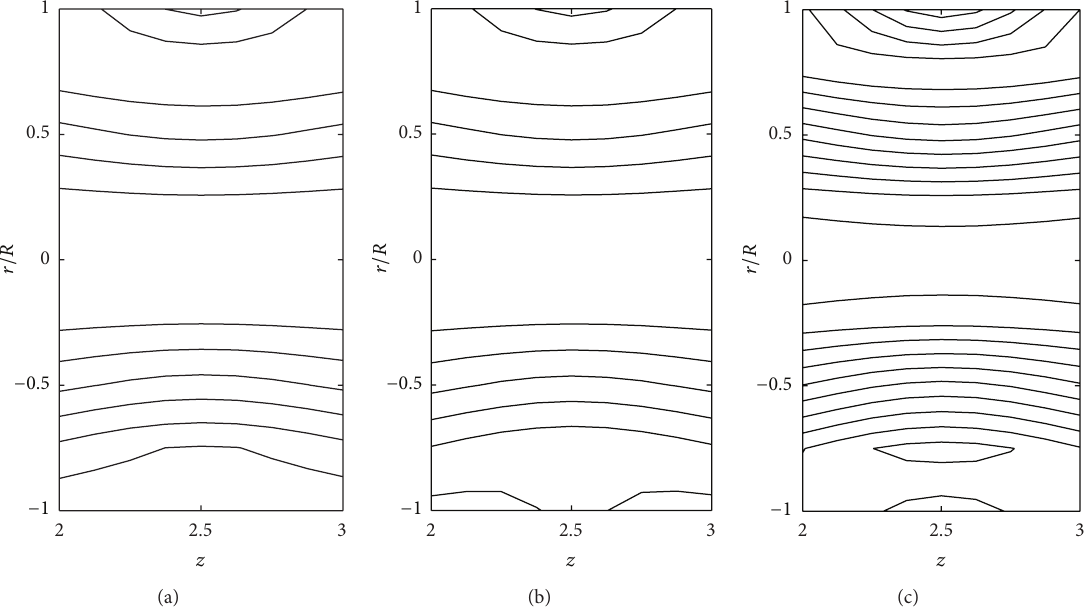
Figure 15: Stream lines for (a) power law fluid, (b) Herschel-Bulkley fluid ( 𝜏 𝑦 = 0.1 ), and (c) Herschel-Bulkley fluid ( 𝜏 𝑦 = 0.4 ) taking 𝛿 1 = 0.2 and 𝜁 = 0.01 in the stenotic